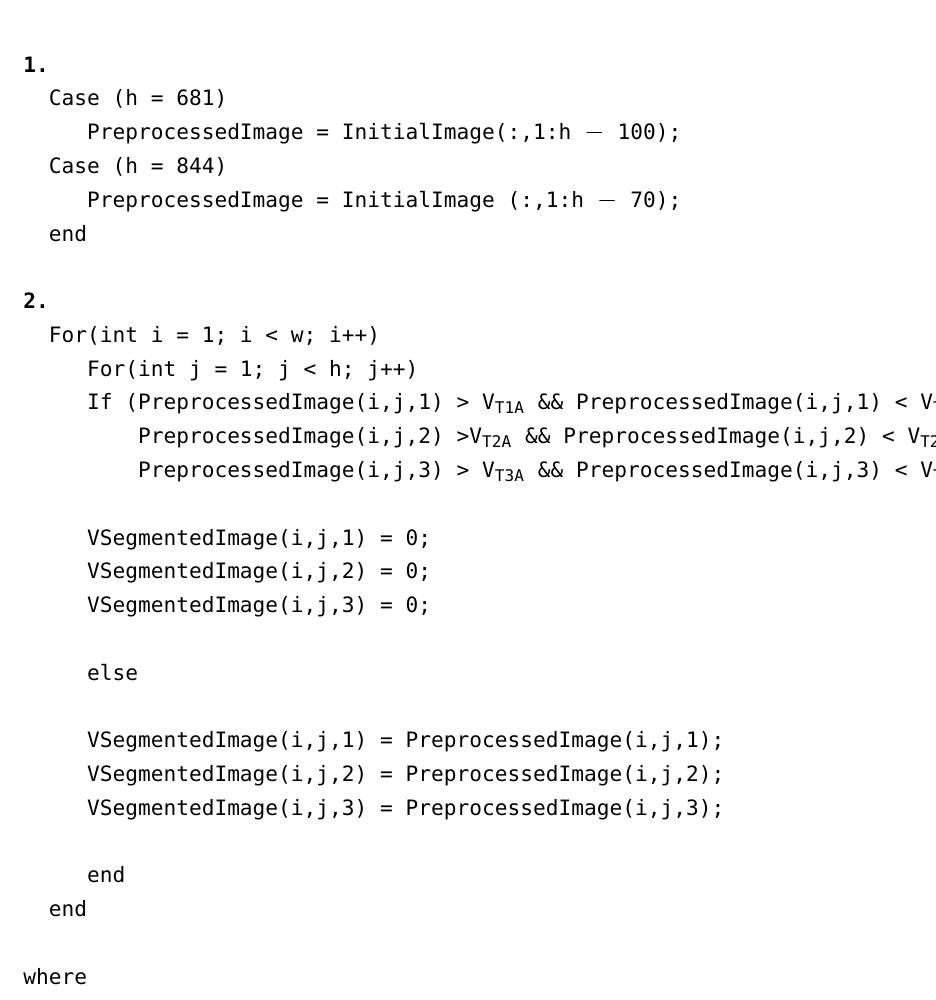
V T1A = minimum threshold for R component of green color identifying vegetation V T1B = maximum threshold for R component of green color identifying